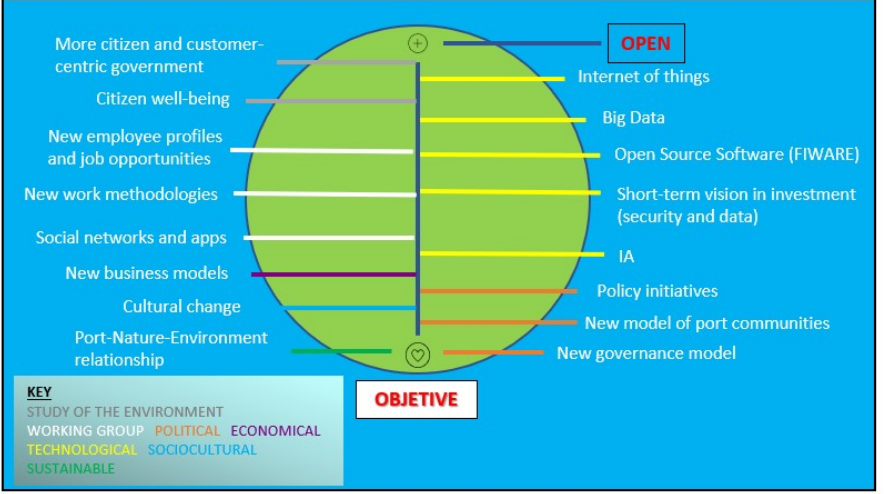
Figure 16. Elements of open ports. Source: own elaboration. In order to generate more collaborative ports, technological indicators will be the most relevant—again big data, AT, Internet of Things, firmware, sensors, robotisation, etc. In this case, to a lesser extent, indicators of sustainable characteristics appear—in this case, only the port–nature–environment relationship indicator would be relevant. In the sociocultural domain, which only includes one related indicator, it will be necessary to strengthen the cultural change.